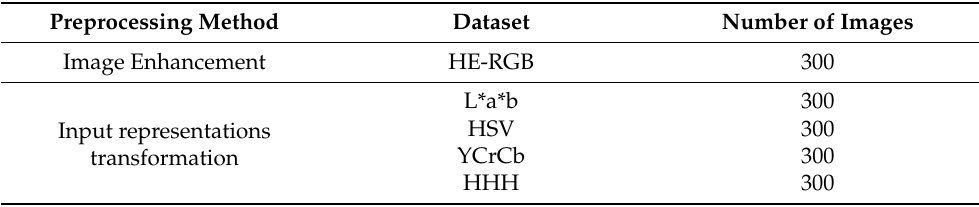
Table 2. Different dataset types generated by image